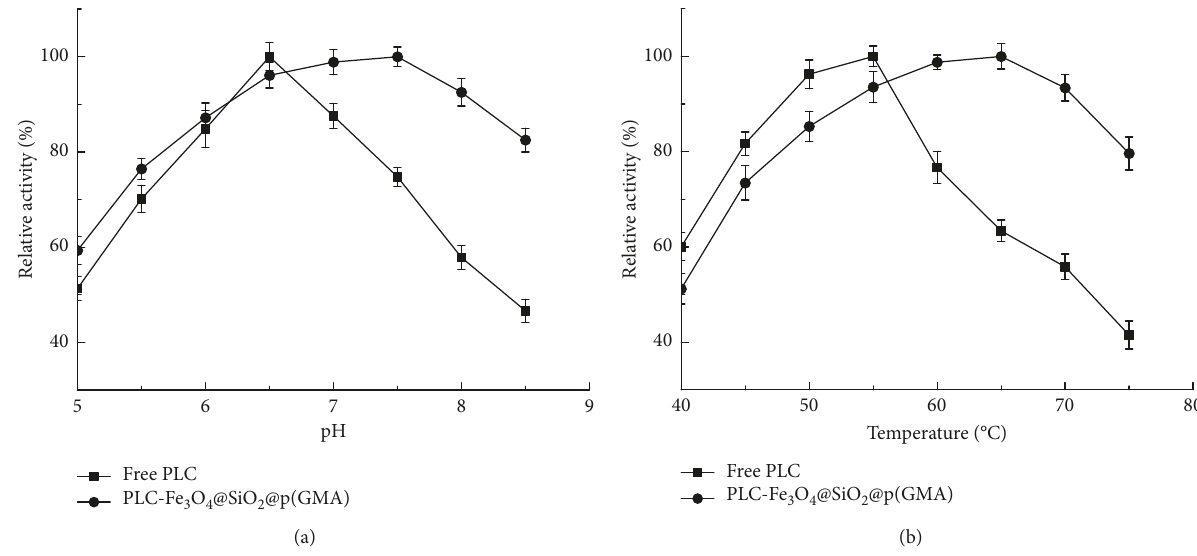
Figure 5: Effect of pH and temperature on the relative activity of free PLC and PLC-Fe 3 O 4 @SiO 2 @p(GMA). Effect of pH on the relative activity of free PLC and PLC-Fe 3 O 4 @SiO 2 @p(GMA) using soybean lecithin emulsions as a substrate at 55 ° C for 2 h. The optimum pH of PLC was 7.5 after immobilizing. Effect of temperature on the relative activity of free PLC and PLC-Fe 3 O 4 @SiO 2 @p(GMA), hydrolyzing soybean lecithin emulsions, was determined within pH 6.5 and 7.5 for 2 h The optimum temperatures of PLC were increased by 10 ° C through immobilizing. The data were reproduced three times, and error bars indicate standard deviations. (a) Effect of pH on the relative activity of free PLC and PLC-Fe 3 O 4 @SiO 2 @p(GMA). (b) Effect of temperature on the relative activity of free PLC and PLC-Fe 3 O 4 @SiO 2 @p(GMA).